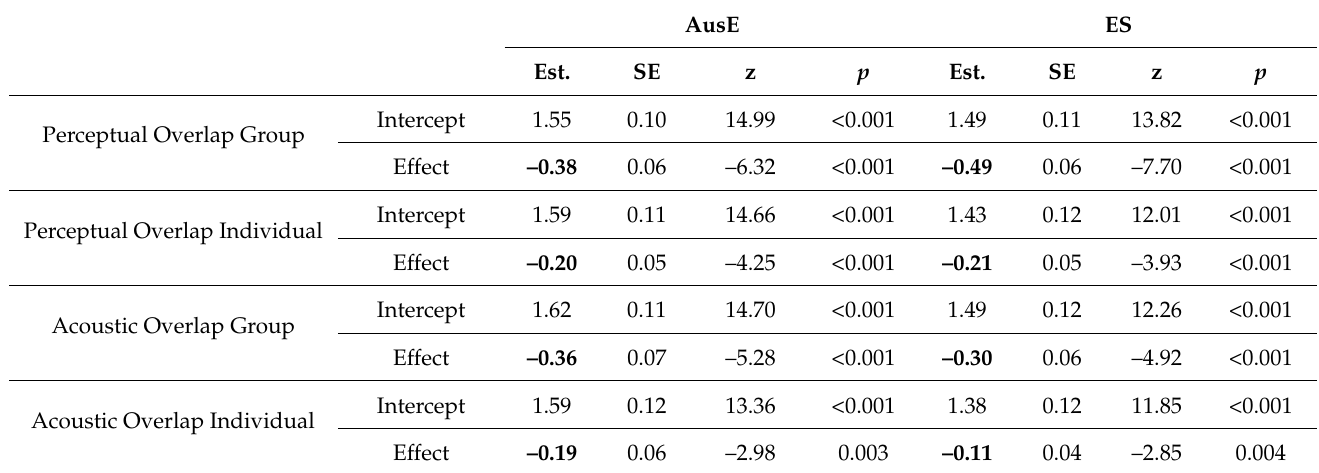
Table 8. Results of the mixed models for acoustic and perceptual models for groups and for